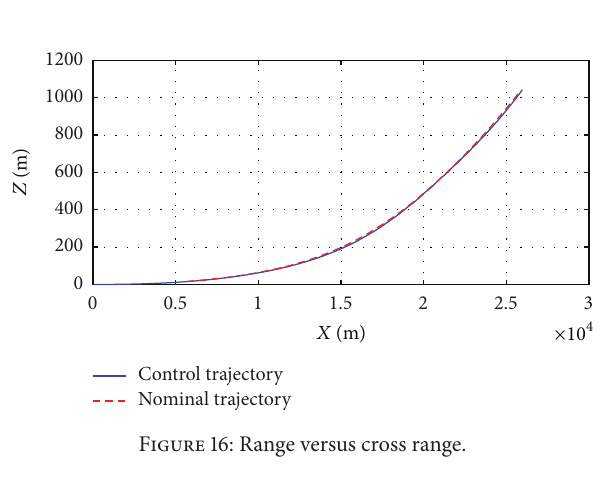
Figure 16: Range versus cross range.